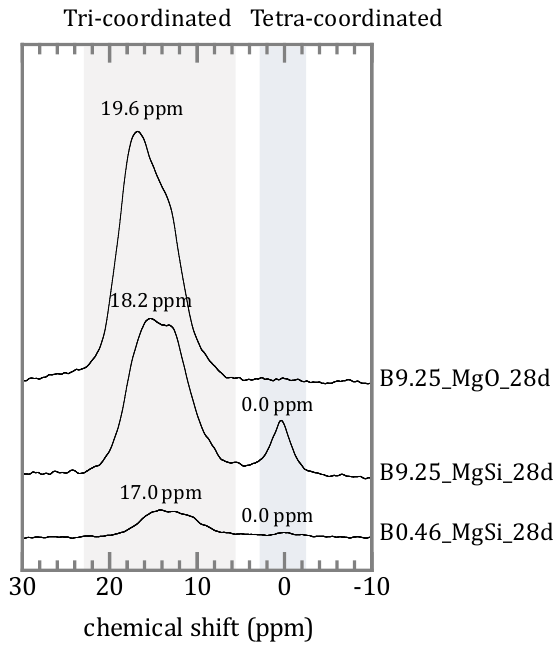
Figure 7. 11 B magic-angle spinning nuclear magnetic resonance (MAS-NMR) spectra of 28-day aged samples with [B] ini = 0.46 mmol/L and silica (bottom spectrum), and with [B] ini = 9.25 mmol/L with (mid) and without silica (top) all aged for 28 days.